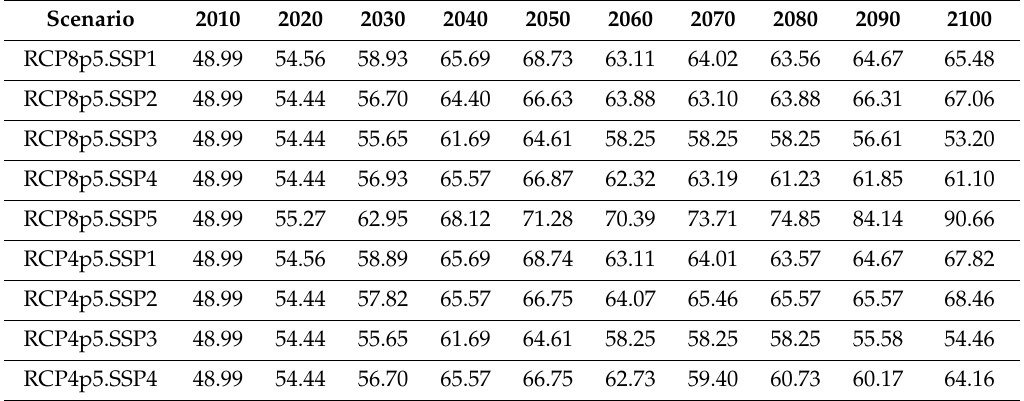
Table A7. Prices—Pulpwood (National average price per m 3 , in USD (exchange rate in 2010)). Scenario